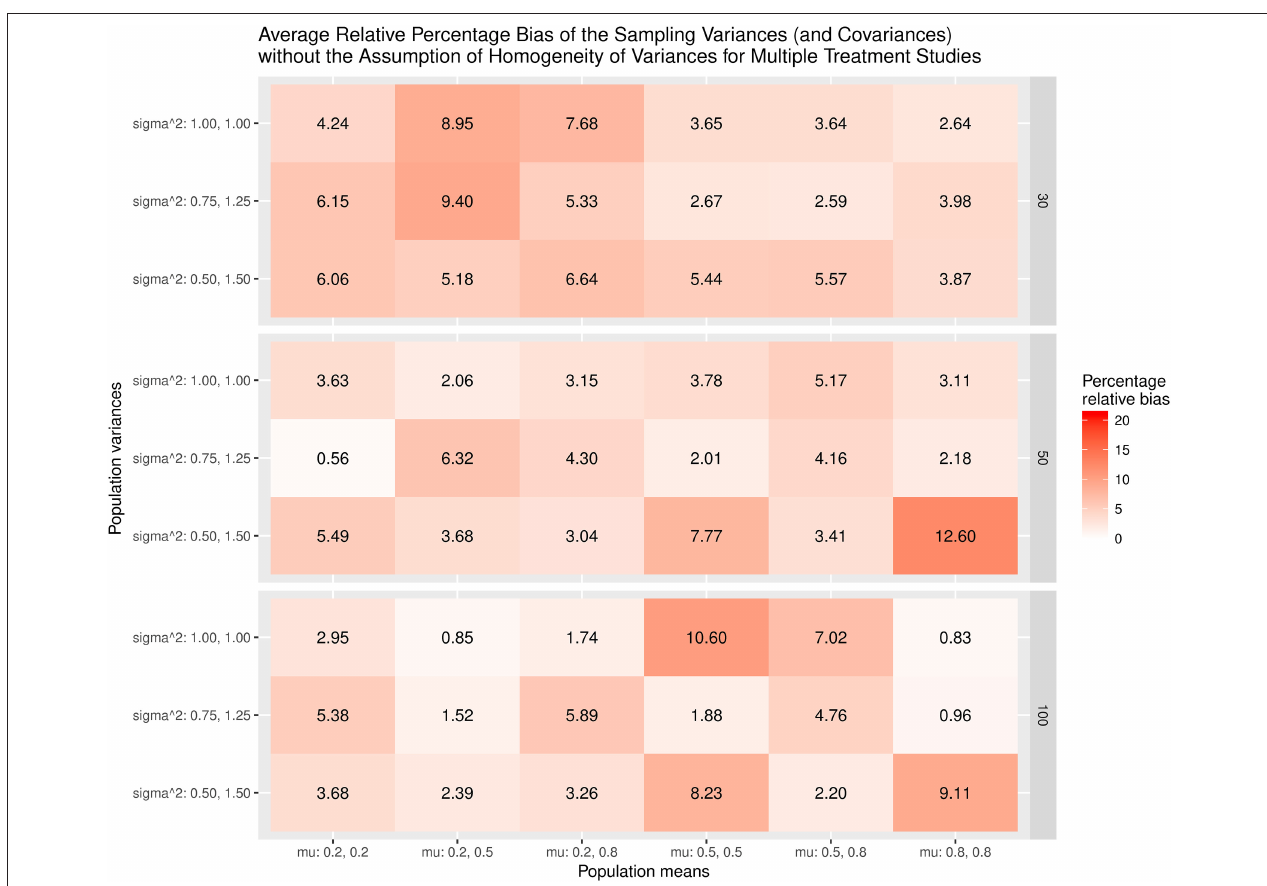
FIGURE 6 | Relative bias of the average of the sampling variances and covariance for the multiple treatment studies without the assumption of homogeneity of variances.